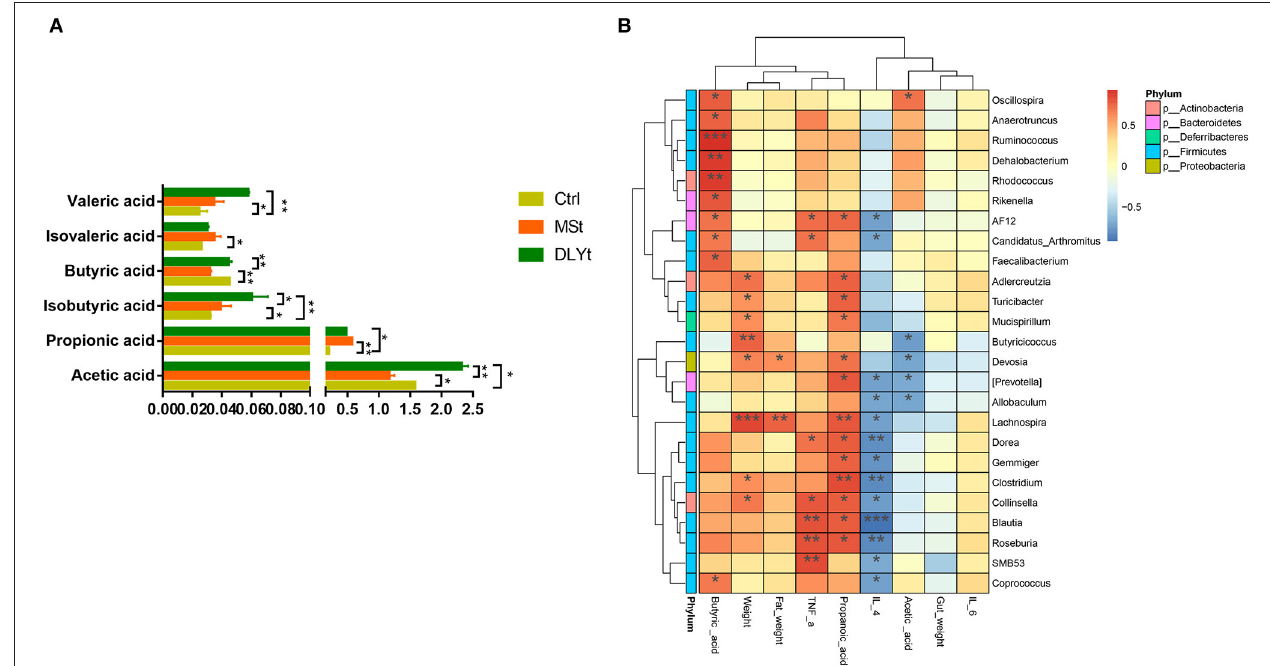
FIGURE 6 | Effects of FMT on the concentrations of short-chain fatty acids during cold exposure. (A) Concentrations of acetic, propionic, isobutyric, butyric, valeric, and isovaleric acids of ileum ( n = 7/group) (* P < 0.05, ** P < 0.01, and *** P < 0.001, Duncan’s multiple range test). (B) Heatmap of intestinal microbiota and relative functions index in the three groups. Heatmap displays Spearman’s rank correlations between the relative abundance of bacterial genus and functional indicators concentrations across the fecal microbiota in the three groups. Only correlations with corrected values of P < 0.05 are illustrated. Blue edges represent negative correlation and pink edges represent positive correlation. The depth of color is proportional to the correlation coefficient (Monte Carlo rank